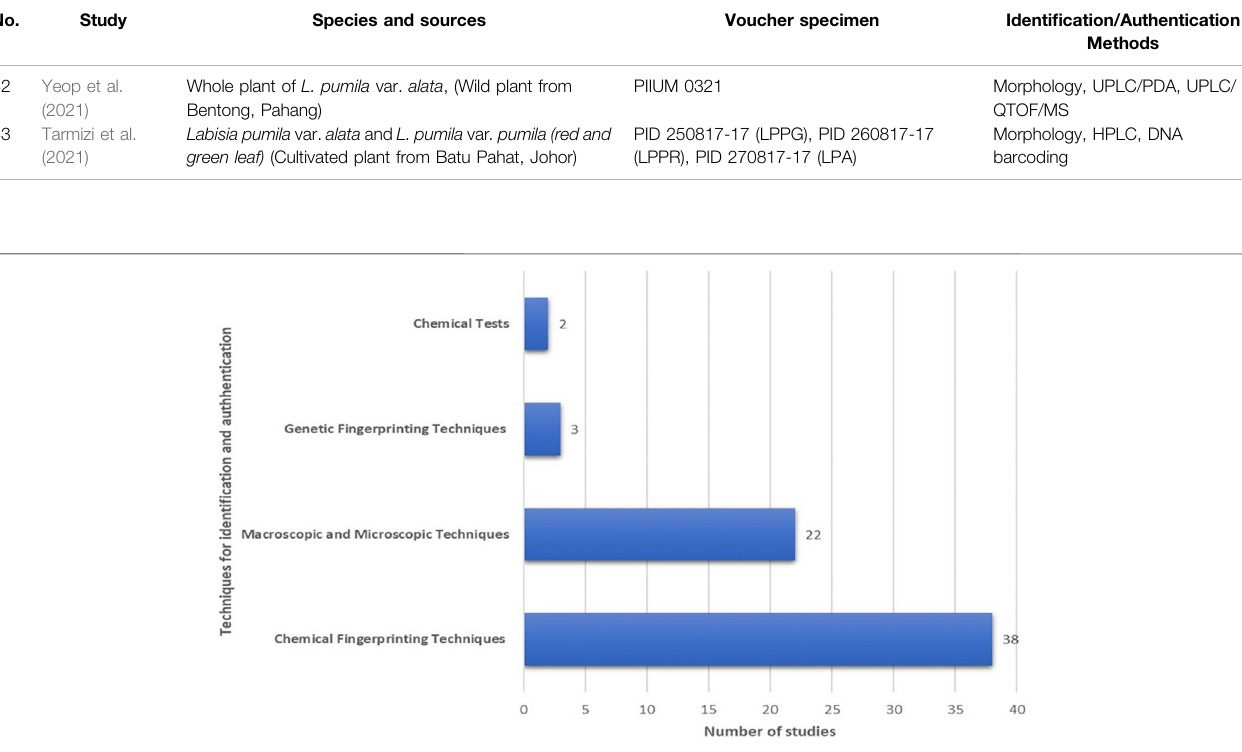
FIGURE 3 | Marantodes pumilum identi fi cation and authentication techniques reported between 2010 and 2021.